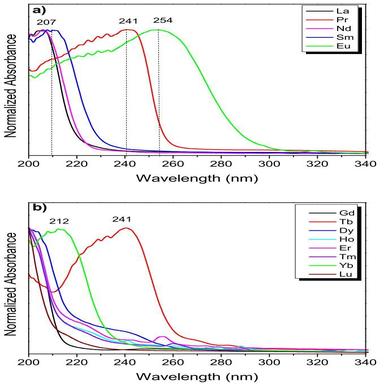
Normalized absorbance spectra for the (a) triclinic and (b) tetragonal Ln2Ge2O7 ceramics in the UV region 200–340 nm. The wavelengths where the absorbance maxima occur are indicated.